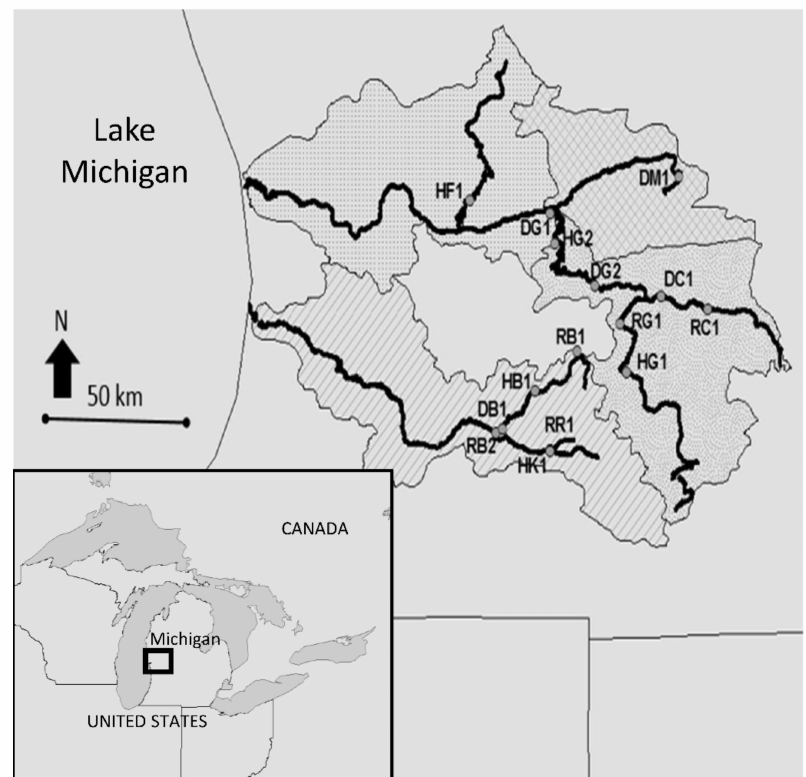
Figure 1. Study area and sampling locations of fifteen sites in the Lake Michigan basin, Michigan, USA. Site codes are listed by anthropogenic barrier-river-upstream/downstream most location. Anthropogenic barriers are D (uncontrolled), H (controlled), and R (removal). Rivers are G (Grand River), B (Battle Creek), M (Maple River), R (Rice Creek), C (Red Cedar River), F (Flat River), and K (Kalamazoo River). River locations are 1 (upstream most site) and 2 (downstream most